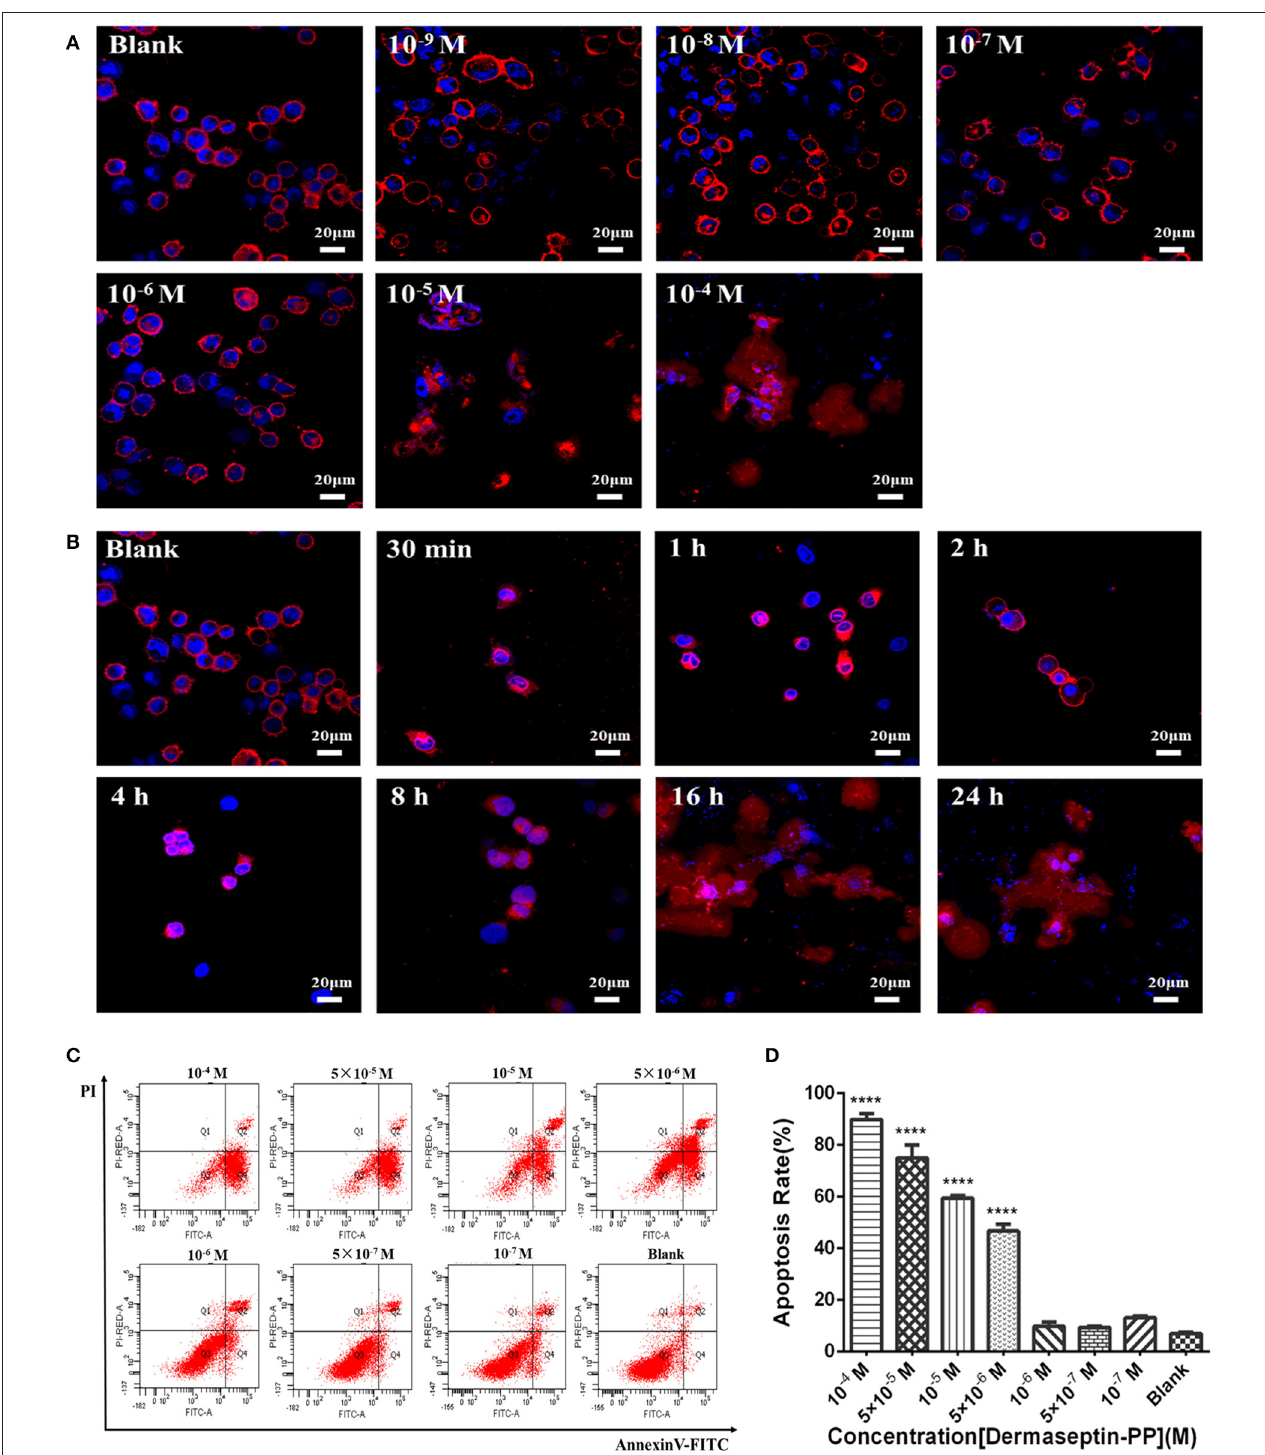
FIGURE 4 | (A) The morphology changes of H157 cells after treatment with gradient Dermaseptin-PP (10 − 4 to 10 − 9 M) for 24h. (B) The morphology changes of H157 cells after Dermaseptin-PP (10 − 4 M) treatment for different time (30min, 1, 2, 4, 8, 16, 24h). The cell membrane and the nucleus were dyed red and blue respectively. The images were observed under the laser confocal microscope by a magnification factor × 60. (C) The representative images of H157 cells treated with different concentrations of Dermaseptin-PP from flow cytometry analysis. (D) The apoptosis rate of H157 cells treated by gradient Dermaseptin-PP (10 − 4 to 10 − 9 M) was quantified based on flow cytometry analysis. Dermaseptin-PP could promote apoptosis of H157 cells from concentration of 5 × 10 − 6 M. All data was represented as the mean ± SEM of three independent experiments. The significance of group differences was determined by P -value. “****” represents P < 0.0001 vs. blank control group (cells without Dermaseptin-PP